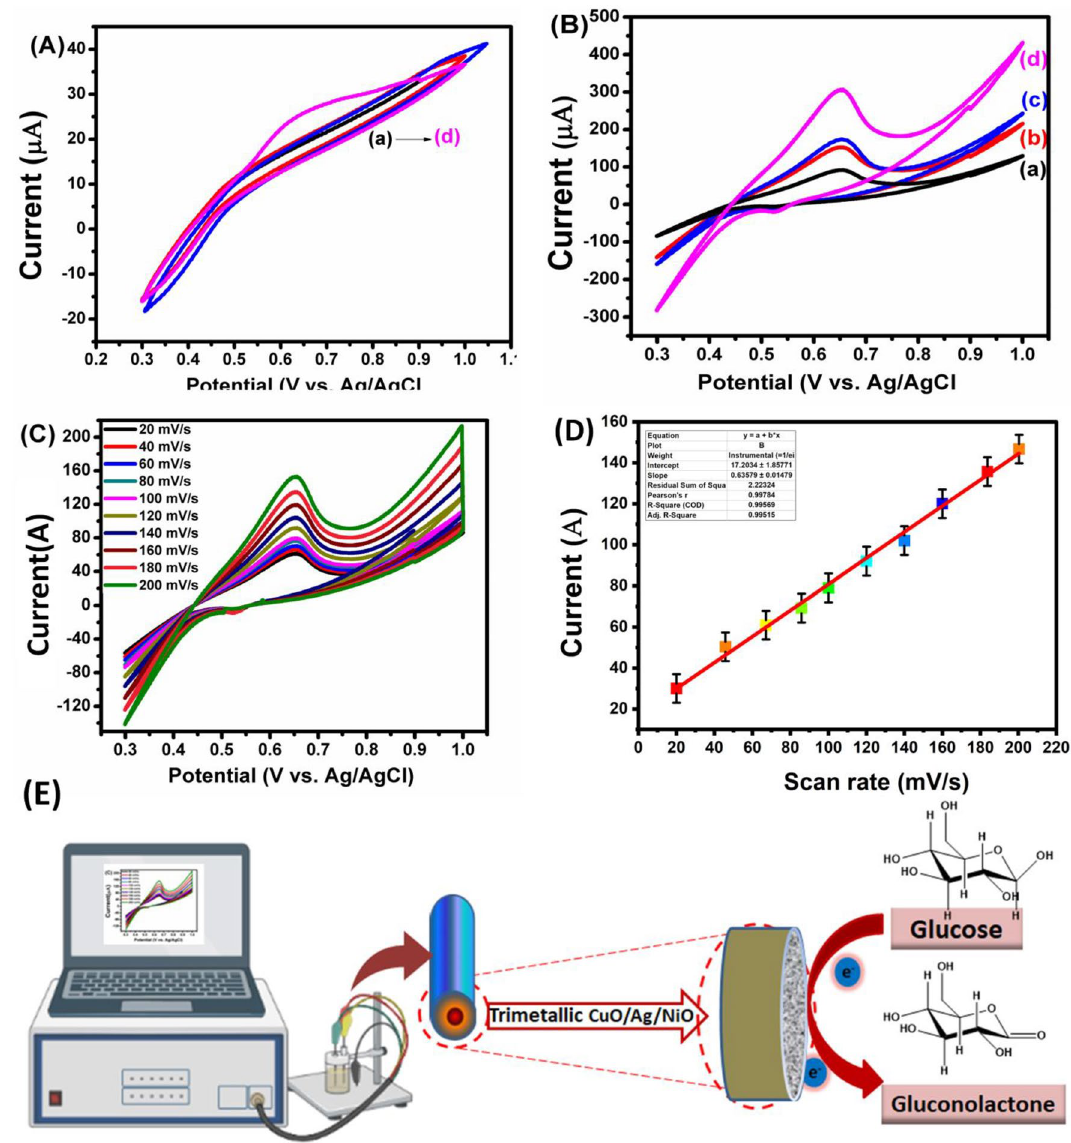
Figure 3. ( A ) Typical CV response of electrodes (a) b–GCE, (b) CuO–GCE, (c) CuO/Ag–GCE, and (d) CuO/ Ag/NiO–GCE in NaOH solution at scan rat, 100 mVs −1 , ( B ) CV curve of different electrodes (a) b–GCE, (b) CuO–GCE, (c) CuO/Ag–GCE, (d) CuO/Ag/NiO–GCE in presence of glucose at the various electrodes (scan rate, 100 mVs −1 ), ( C ) The CV curve of CuO/Ag/NiO–GCE in 0.1 mM glucose at scan rates (20–200 mVs −1 ), and ( D ) calibrated peak current vs. scan rate graph. ( E ) Schematic representation of trimetallic electrode for producing glucose to